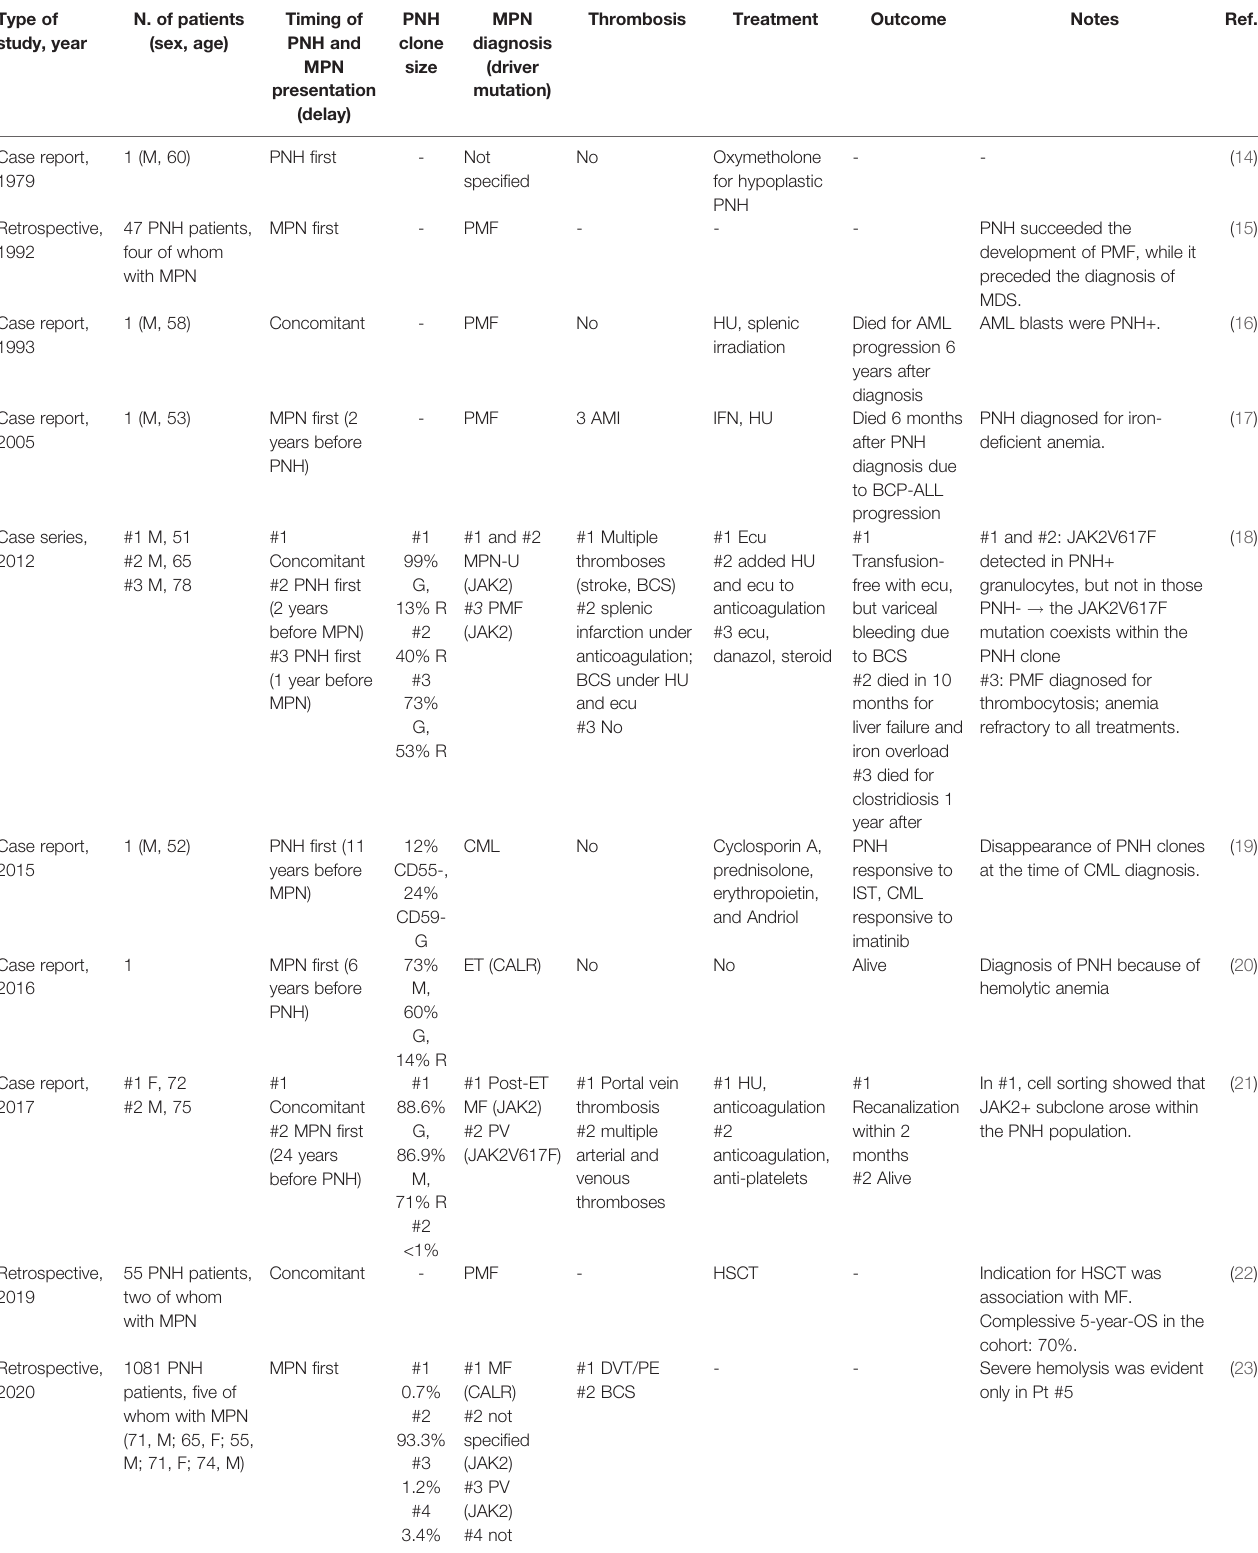
TABLE 2 | Association of MPNs and